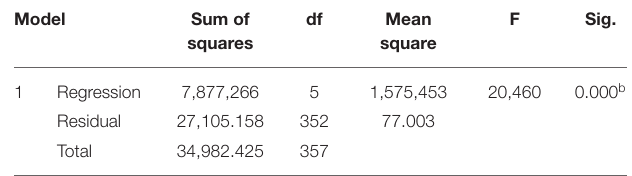
TABLE 4 | Indonesia.